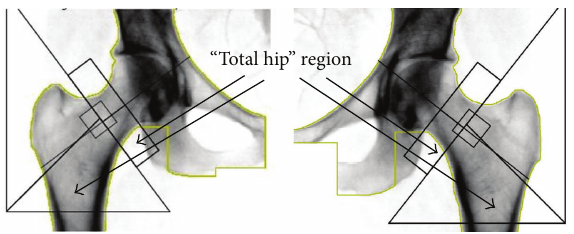
Figure 1: Dual-energy X-ray absorptiometry total hip scan region, which is the sum of the rectangle and triangles and is also the region we used for bone marrow fat quantification of the femoral necks in the present